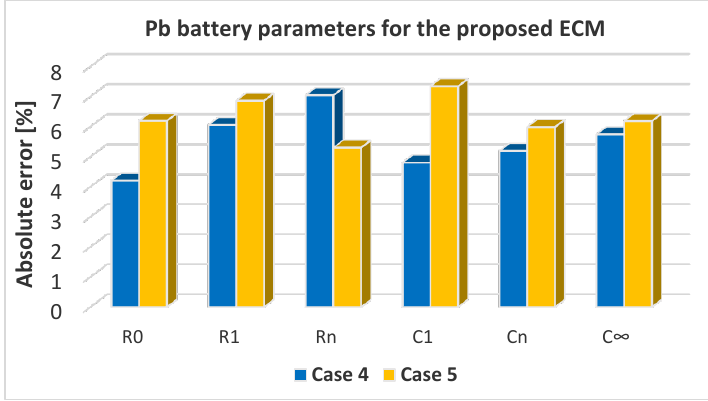
Figure 17. Error plot of Pb battery plot for each of the parameters.